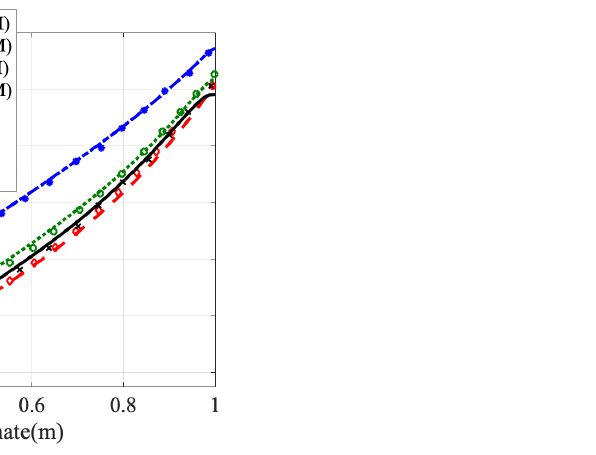
Figure 12. Normal contact pressure for four different thermal models in comparison with Kohei and Bahmani [52].